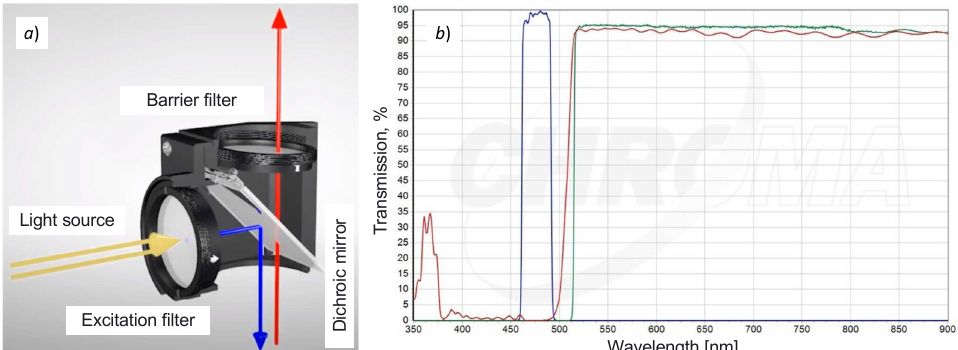
Figure 1. Filtering system of a conventional fluorescence microscope. ( a ) Operation of a fluorescence filter cube and ( b ) transmission spectra of the optical components of a longpass filter cube for FITC